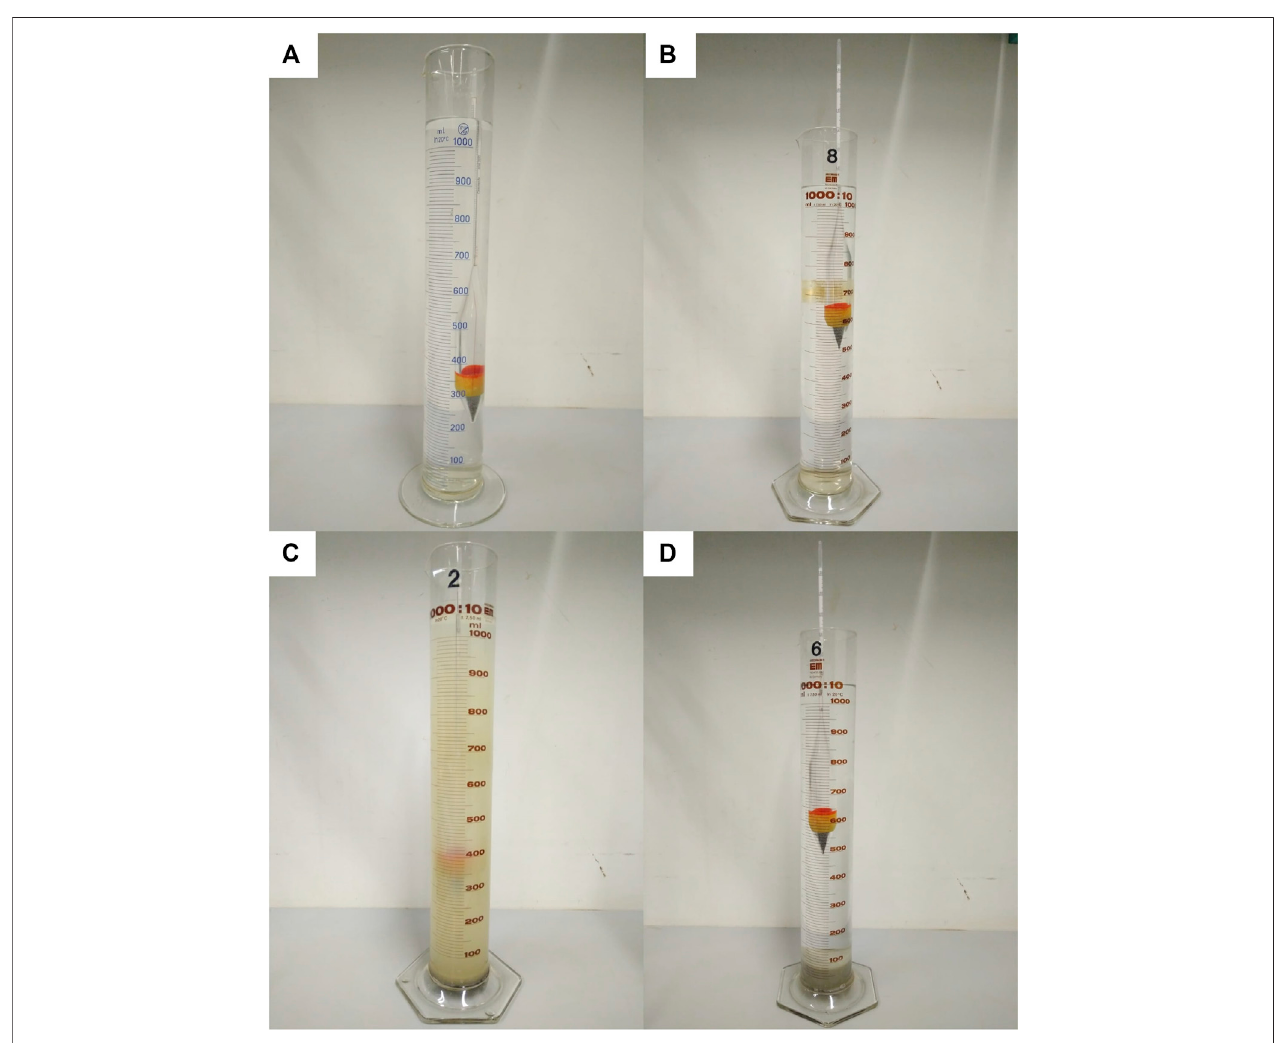
FIGURE 2 | Examples of the immersion depth of the hydrometer in (A) DI-water, (B) salt water 35 PSU, (C) DI water with clay suspension, and (D) salt water 35 PSU with clay suspension. The images with suspensions were taken after 24 h observation time. Note in (D) how the clay is already deposited at the bottom of the